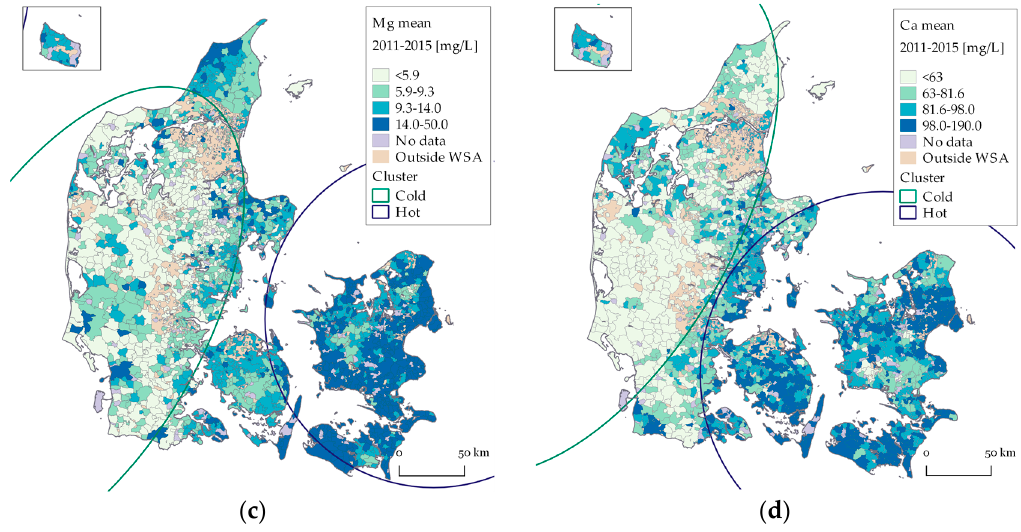
Figure 3. Spatial distribution of mean concentration of ( a ) Na; ( b ) K; ( c ) Mg; and ( d ) Ca, 2011–2015. Concentrations are shown in quartiles. In ( b ), Bornholm is included in the hot spot cluster. Table 2. Statistical significant clusters ( p ≤ 0.05) of high (hot spot) and low concentrations (cold spot) of Na, K, Mg and Ca in drinking water. Up to 50% of the data points were included in the clusters,